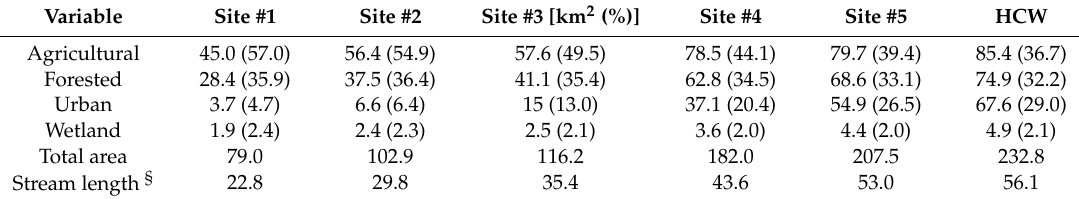
Table 1. Cumulative land use and land cover (LULC), drainage area, and stream length corresponding to each gauging site located in Hinkson Creek Watershed (HCW), Missouri, USA. Percent cumulative LULC is shown parenthetically.